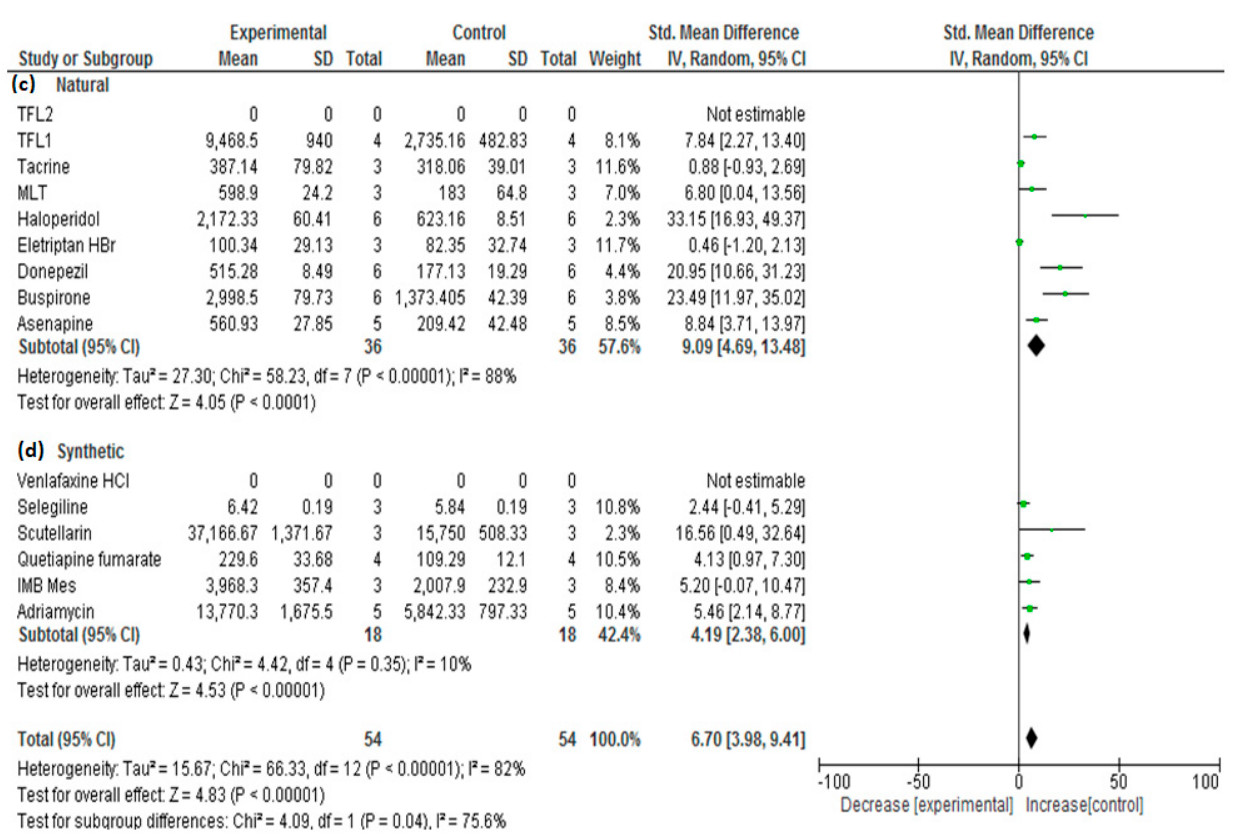
Figure 9. Forest plot of investigated subgroups: (c) naturally originated material of nanoparticulate systems versus (d) synthetically originated material of nanoparticulate system for the studies: [1–3,5–8,11–17,19], (Review Manager).